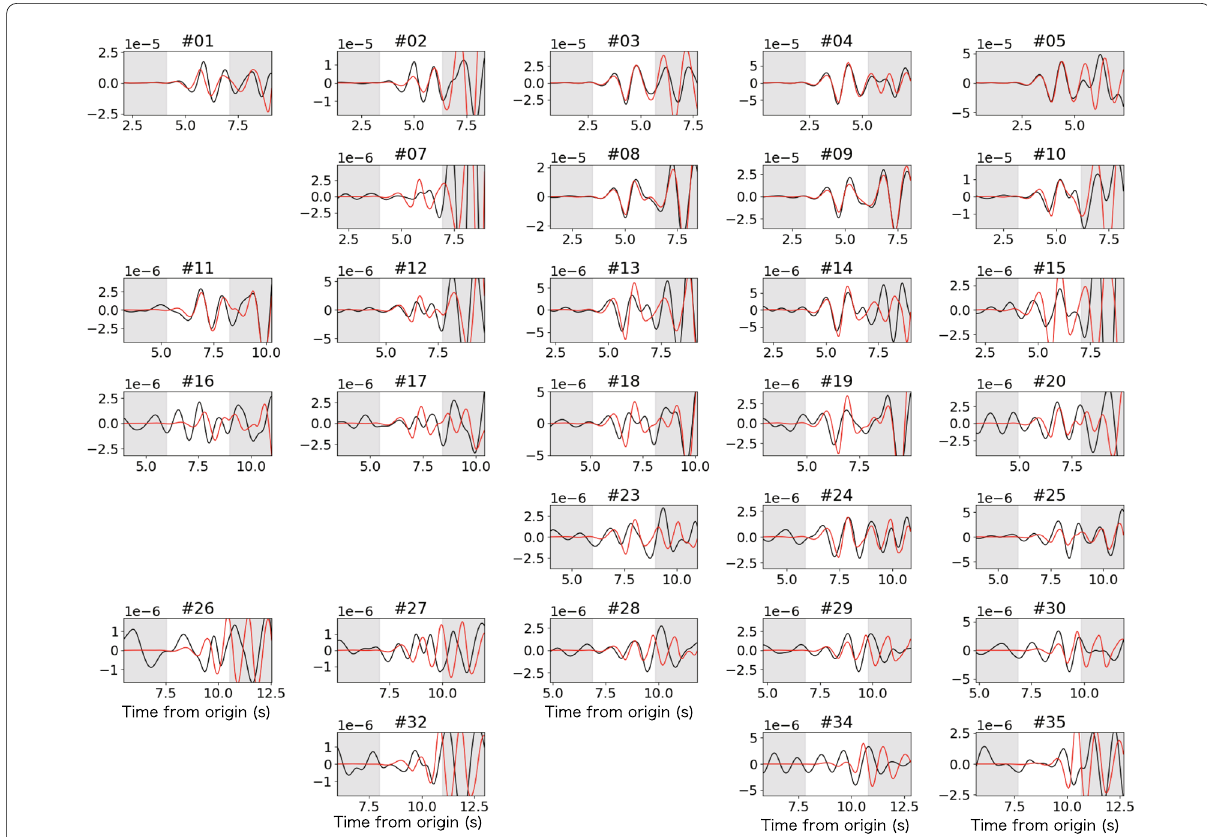
Fig. 4 Comparison of observed and synthetic seismograms for the earthquake ( M w = 4.0 ) that occurred at 9:06, March 16, 2011 (JST). The black and red lines show observed and synthetic seismograms, respectively. The station numbers are shown in Fig. 1b. The white-colored area shows the used time windows. Note that we did not use station #05, because the raw seismogram before applying the bandpass filter was saturated in 5 s from the beginning of the time